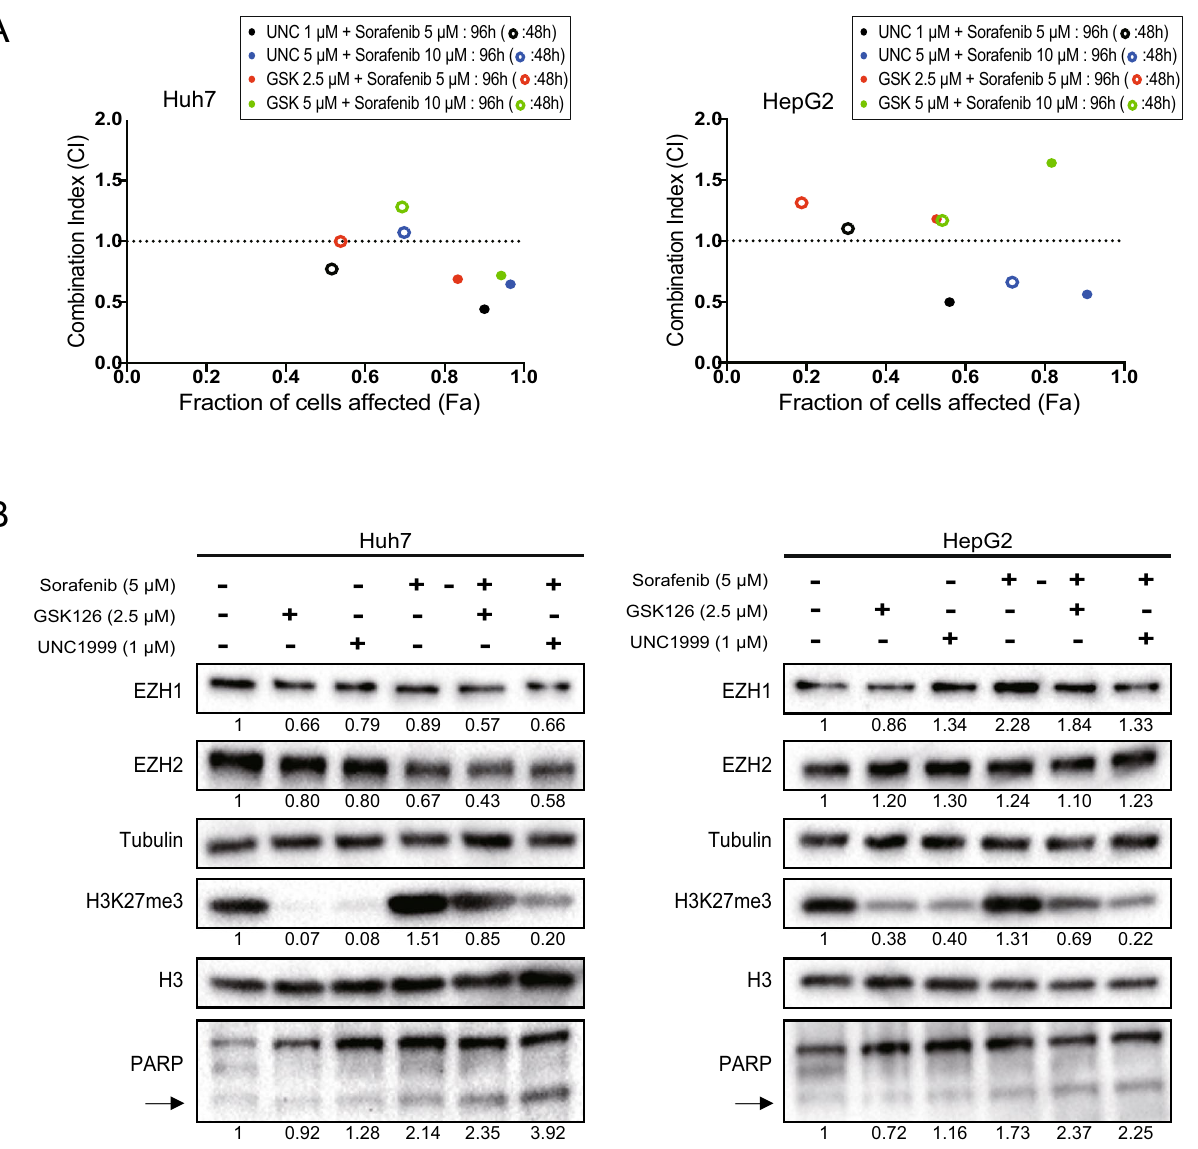
Figure 5. Combined use of sorafenib and GSK126 or UNC1999 in liver cancer cells. ( A ) The combination index was calculated based on the data of the trypan blue dye exclusion test. ( B ) Cells treated with sorafenib and GSK126 or UNC1999 for 48 h were subjected to Western blot analyses. The arrow indicates the cleaved form of PARP. RI was shown as the means of three independent